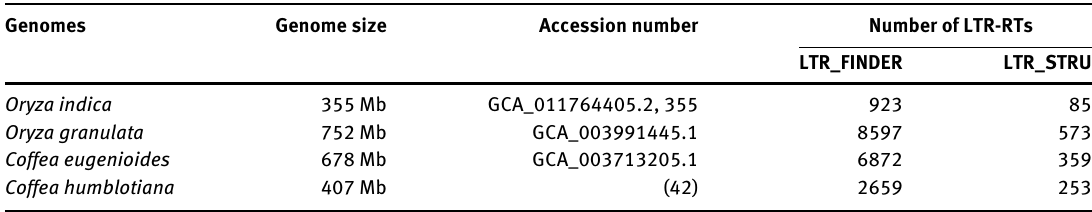
Table 3: Number of predicted LTR-RTs with LTR_FINDER and LTR_STRUC software. Genomes